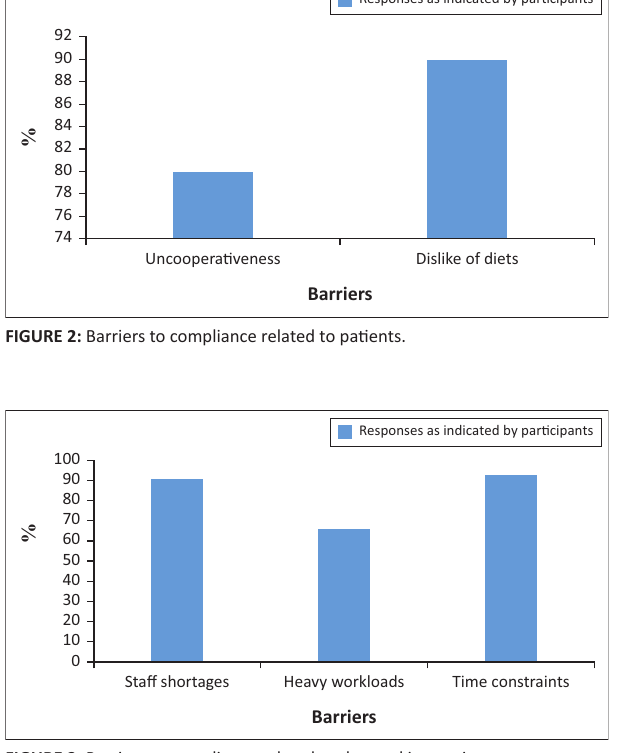
FIGURE 3: Barriers to compliance related to the working environment.